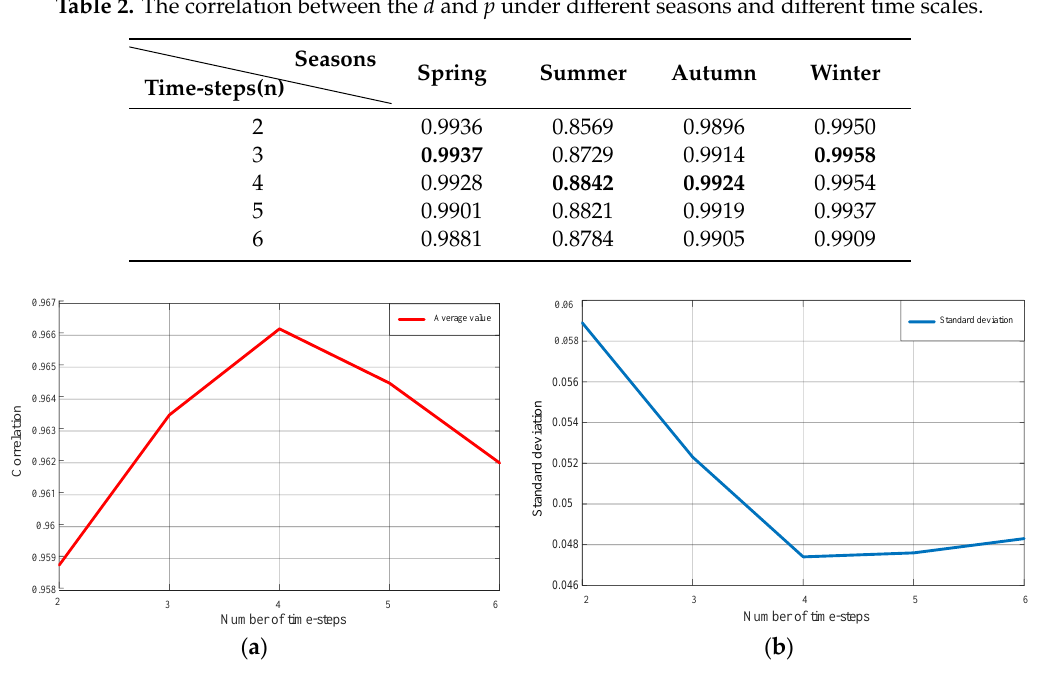
Figure 4. ( a ) The mean value of ρ d,p in different time-steps; ( b ) Standard deviation of ρ d,p in different time-steps.